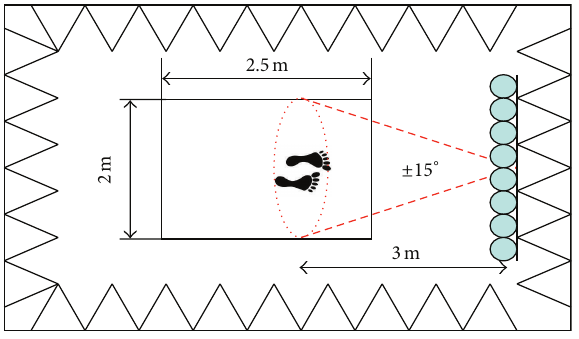
Figure 4: Scanning and positioning